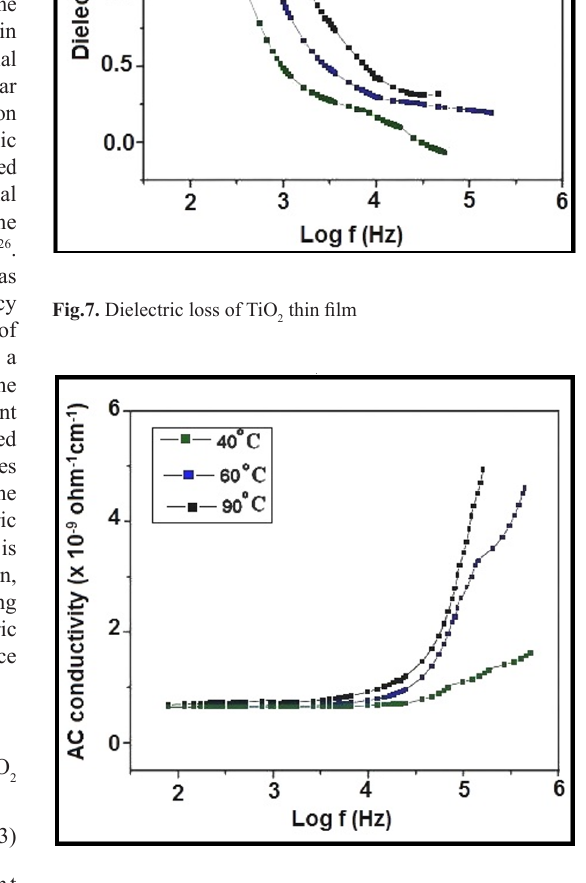
Fig.8. Variation of conductivity with log